Question: Describe this figure in one sentence.
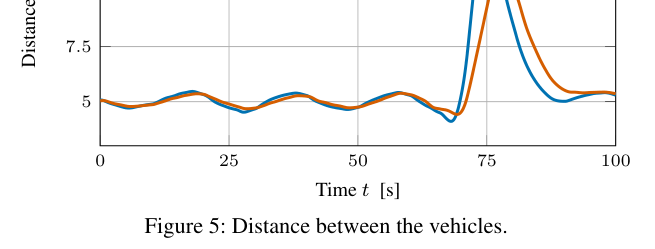
Answer: shows two additional metrics: the first one is the average MCS, ¯m, computed in the same way as the other metrics from the wireless network stack; the second one is the end-to-end delay measured at each vehicle and averaged, ¯d. We can observe that the MCS actually decreases when the RSRP decreases at t = 20 s and t = 70 s, confirming our observation related to the results in Fig. 3. We also notice that, during this low- RSRP transient, the delay experienced at the upper layers (and specifically at the application layer) increases dramatically and exceeds 200 ms. This is due to the high number of HARQ retransmissions performed at the link layer during the BLER spike. In fact, by analyzing the network stack, we observe up to 100 retransmissions per second during these transients. Fig. 5 finally shows the behavior of the platoon during the experiment. In normal conditions, i.e., as long as the delay experienced by the CACC application is below the 300 ms target, the distance oscil